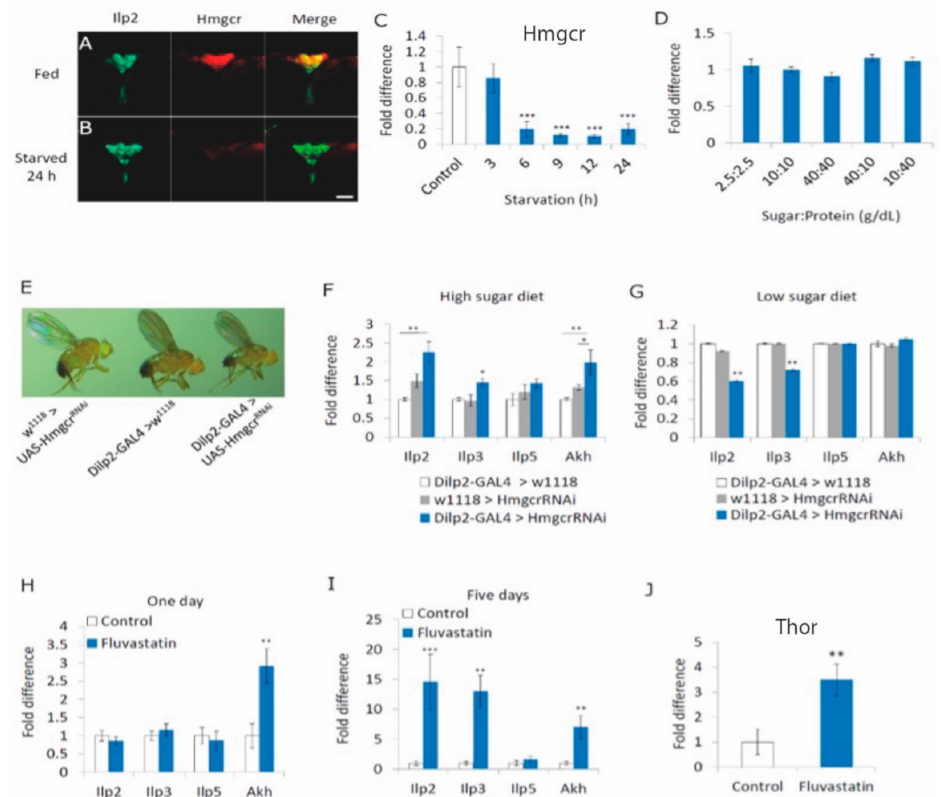
Figure 1. Hmgcr expression in the insulin-producing cells is regulated by starvation. ( A , B ) Immuno- histochemical staining of brains from either equally aged ( A ) normal fed or ( B ) 24 h starved Drosophila adult males (5–7 days old). Insulin-like peptide 2 (ILP2) (green) and β -galactosidase in an Hmgcr expression pattern (red); yellow indicates overlapping expression ( A , B ): n = 10 males per parameter, size bar = 50 µ m). ( C ) To examine how starvation affects Hmgcr transcript levels, RNA was extracted from whole flies fed a high-sugar diet, as well as after various times of starvation. ( D ) To examine how the nutritional state affects Hmgcr transcript levels, RNA was extracted from equally aged 5–7 day old male heads under different nutritional states. ( C , D ): Flies fed normal food ad libitum were set as 100%, represented by 1 on the graphs. n = 10 replicates, each replicate consisted of 25 male fly heads. To detect the significant difference between groups a Shapiro–Wilk test was performed to determine normality, then a one-way ANOVA with Tukey’s post hoc test for multiple comparisons was performed, *** p < 0.005). ( E ) Equally aged controls ( w 1118 > Hmgcr RNAi , Dilp2-GAL4 > w 1118 ) or where Hgmcr is knocked down in the pars intercerebralis IPCs ( Dilp2-GAL4 > Hmgcr RNAi ), showing that the Hmgcr males are smaller than equally aged control flies. This experiment was repeated five times, with each replicate consisting of 10 males (5–7 days old) per genotype. ( F ) Equally aged controls and Hmgcr males maintained on a high-sugar diet (58 g/dL sugar:12 g/dL protein) were collected and processed for qPCR. ( G ) Equally aged controls and Hmgcr males, 5–7 days old, maintained on a low- sugar diet (10 g/dL sugar:10 g/dL protein) were collected and processed for qPCR. ( H ) Wild-type male flies were fed 0.5 mM fluvastatin for 24 h before being processed for qPCR. ( I ) Wild-type male flies were fed 0.5 mM fluvastatin for 5 days before being processed for qPCR ( F – I ): n = 10 replicates per genotype, with 25 fly heads per replicate for Ilp2 , Ilp3, and Ilp5 , or 10 bodies per replicate for Akh . To detect the significant difference between groups, a Shapiro–Wilk test was performed to determine normality, then a one-way ANOVA with Tukey’s post hoc test for multiple comparisons was performed, * p < 0.05, ** p < 0.01). ( J ) Wild-type male flies were fed 0.5 mM fluvastatin for 24 h before being processed for qPCR ( n = 10 replicates per genotype, with 10 bodies per replicate for Thor). In all graphs, error bars =